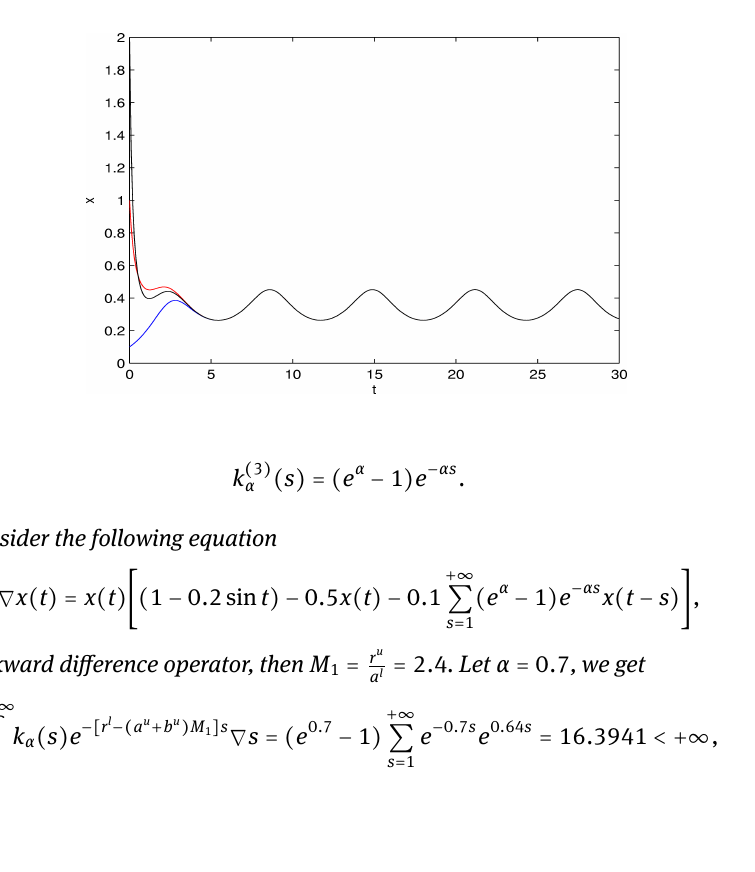
Fig. 2. Graphs of the solution x ( t ) of (23) with α = 4 and the initial values ( x ( 0 ) , y ( 0 ) , z ( 0 )) = {( 0.1,0.1,0.1 ) , ( 1,1,1 ) , ( 2,2,2 )}